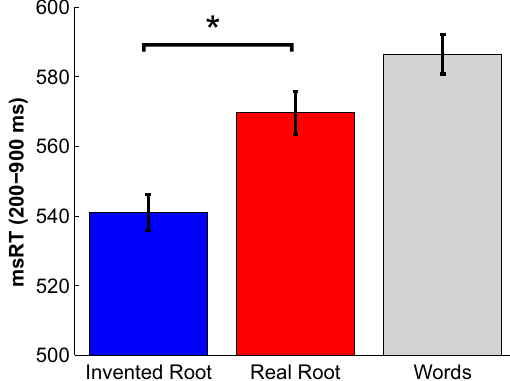
Figure 3. The effect of morphological structure on microsaccade inhibition. msRT is presented for each condition (same color scheme as in Fig. 2). Only trials that included a microsaccade in the specified time window (200–900 ms) were included in the calculation (about 67% of the trials in each condition). Data were normalized (de-meaned) per subject, averaged across subjects (N = 16) and adjusted by adding the group grand-average (see Methods). Error bars denote standard errors across subjects. Microsaccades in Real-root trials were significantly delayed compared to Invented-root trials (nonparametric permutation test). * p < 0.001.